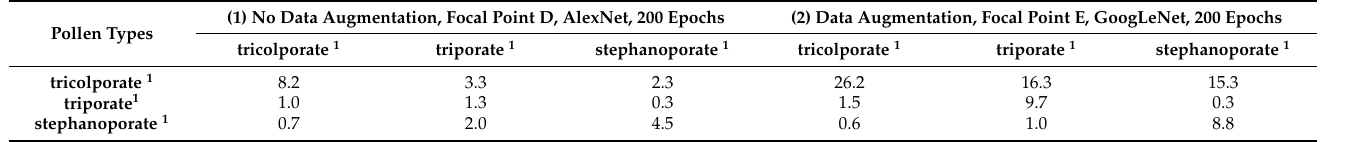
Table 4. Misclassification rates for each pollen type, normalized by the number of trees per pollen